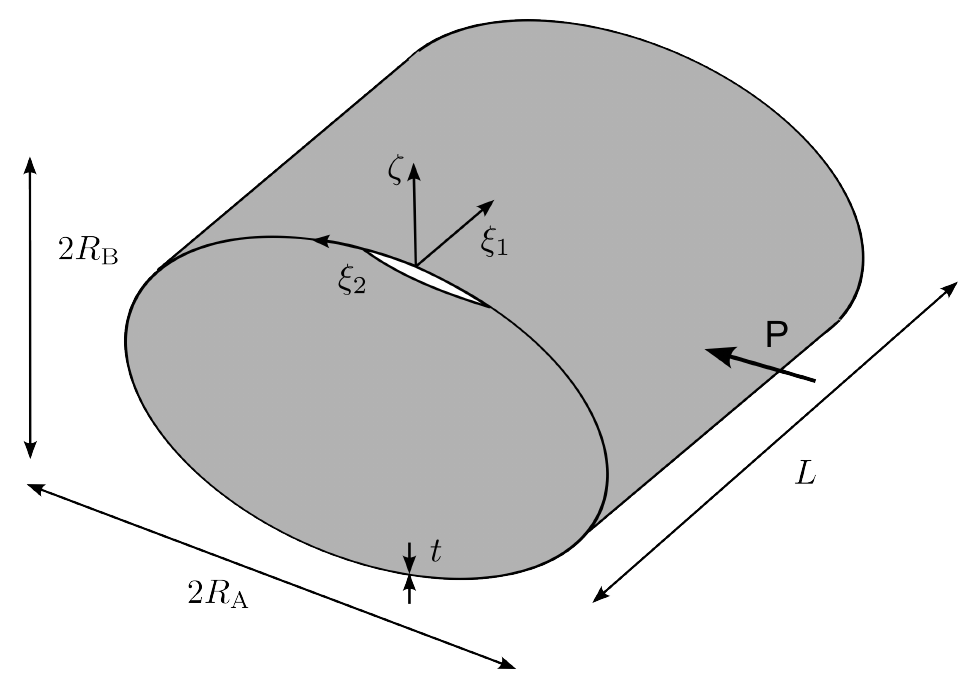
Figure 9. Cylindrical elliptical shell: geometry. The numerical model consists of a coarse mesh with five elements along the circum- ferential direction and two along the axial one, see Figure 10. The polynomial order is p = 10.